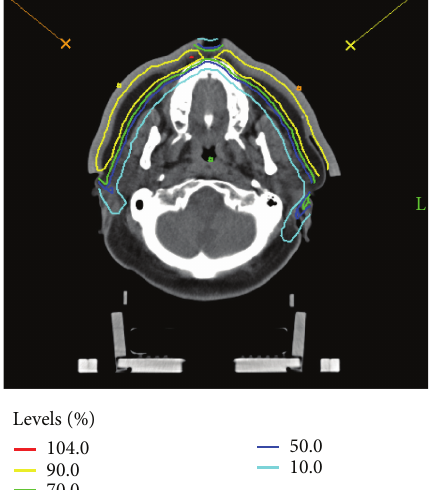
Figure 4: Dose distribution of 6 MeV electrons with customized bolus face mask in place; dose was prescribed to the 90% isodose line (yellow